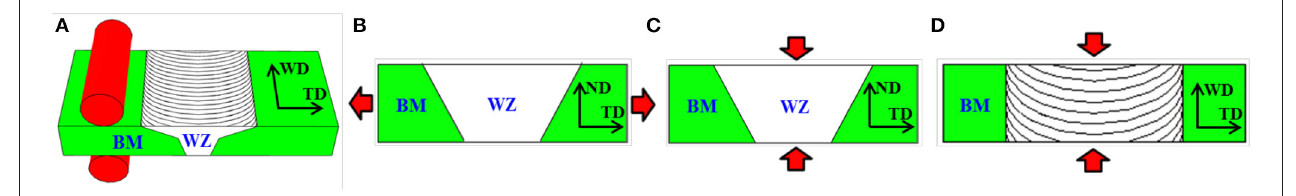
FIGURE 10 | Schematic illustration of the post-weld deformation of FSW AZ31Mg alloys: (A) rolling, (B) tension along TD, (C) compression along ND, (D) compression along WD.